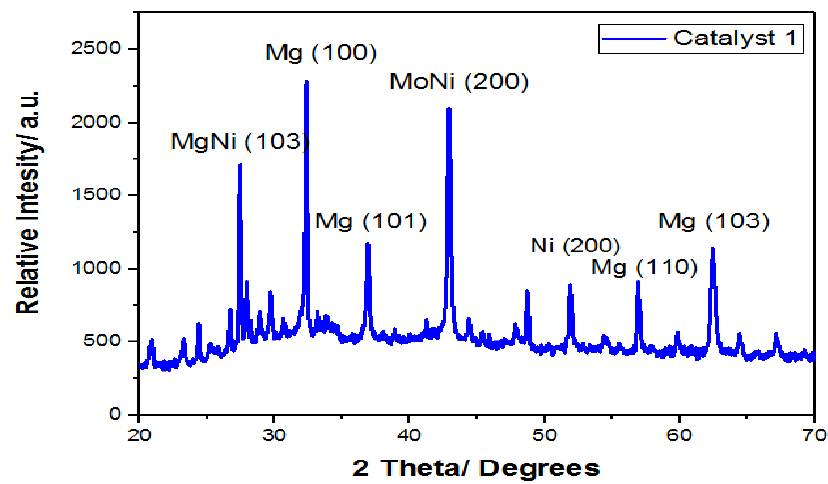
Figure 8. XRD of the optimized molar ratio of Ni/Mo/Mg (4:0.2:1) catalyst.